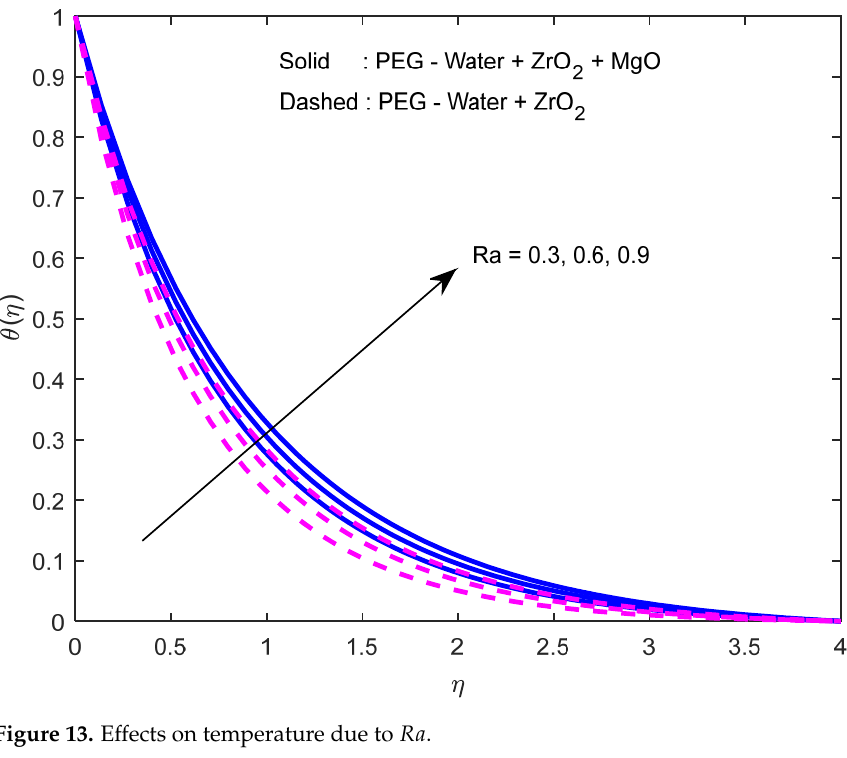
Figure 13. Effects on temperature due to Ra .